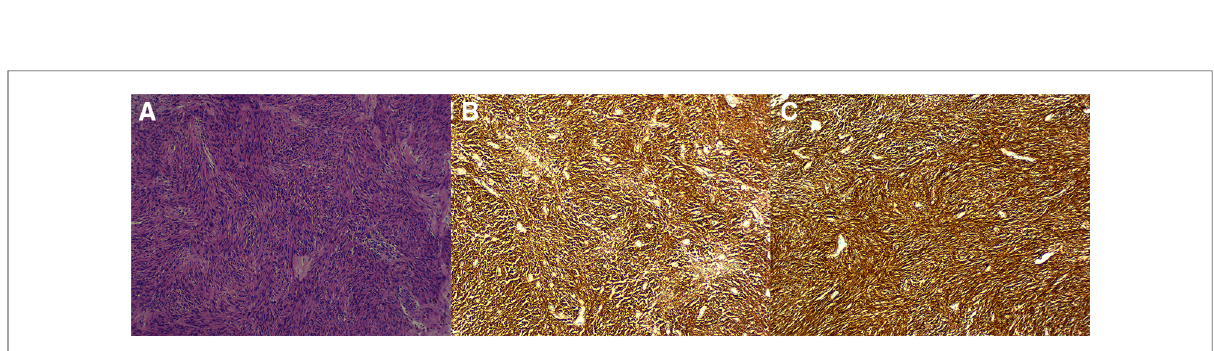
FIGURE 2 Intraoperative photograph showing a large cystic tumor arising from the ileum ( A ), communicating with the ileum via a small intestinal fi stula (red arrow, A,B ). The red arrow indicates the thickening of the cystic wall, which was the solid component of the tumor (red arrow, C ). The last photo shows pus within the tumor ( D